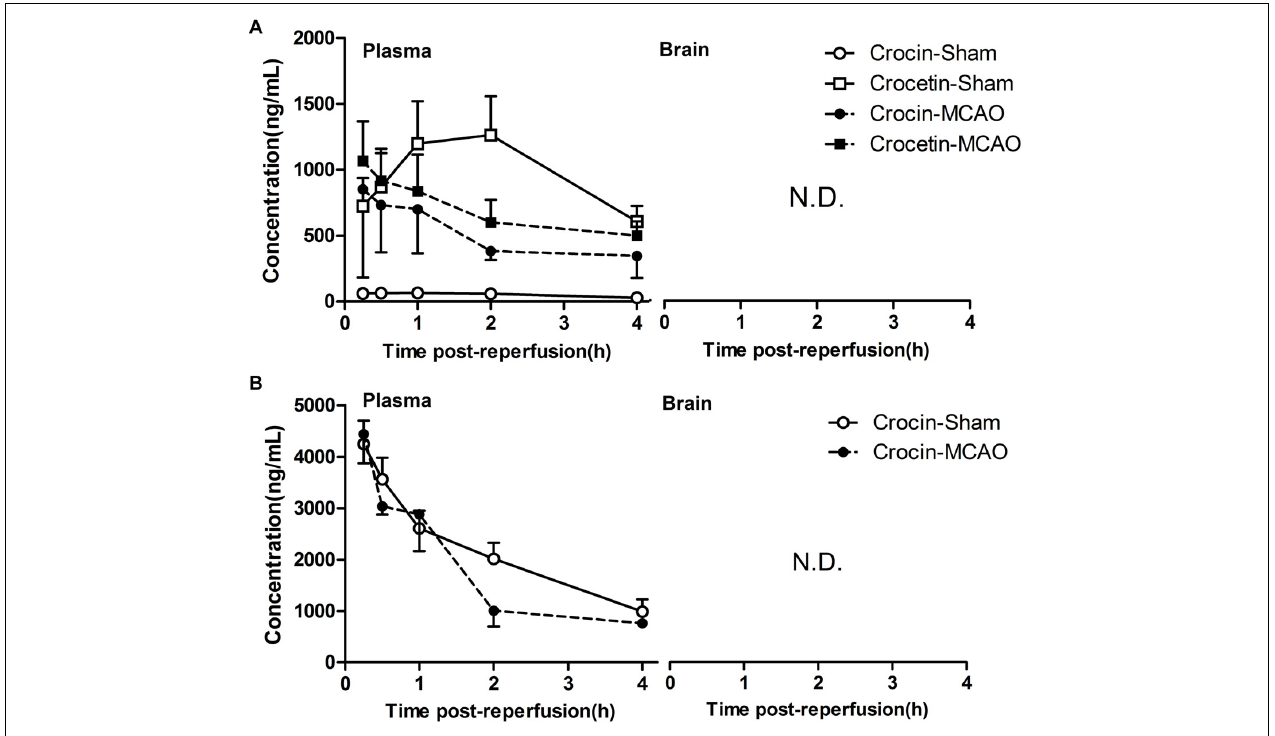
FIGURE 3 | Neither crocin nor its metabolite, crocetin, could enter the brain in the normal and cerebral I/R rats. (A) Oral administration of crocin (60 mg/kg). (B) Intravenous administration of crocin (1 mg/kg). Data are expressed as the mean ± SD ( n = 5). N.D., under the lower limit of detectability (2 ng/mL).